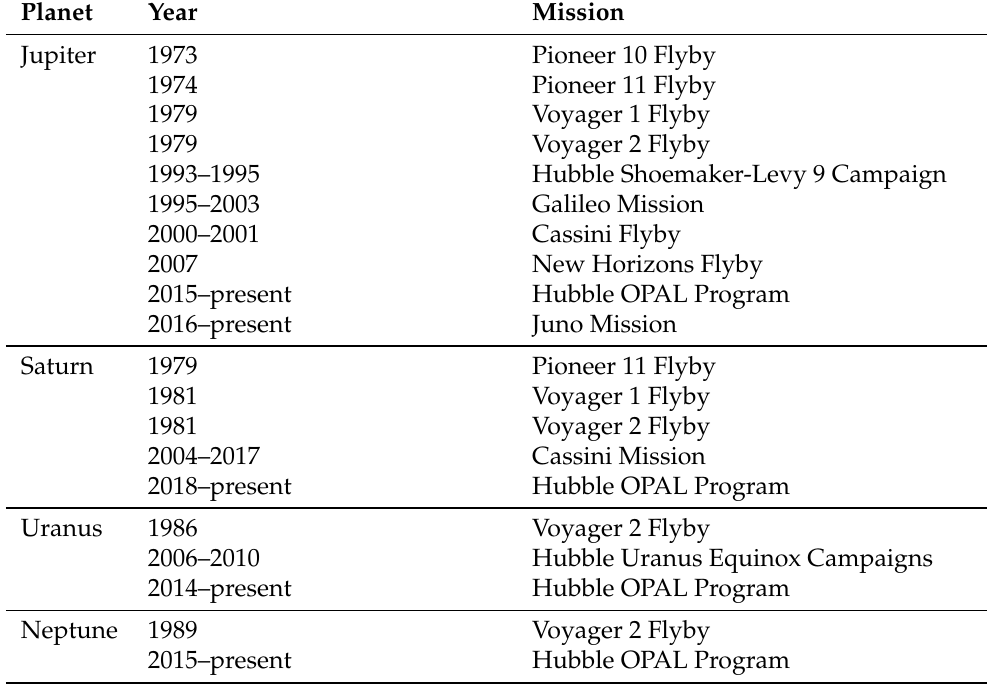
Figure 1. Timeline of spacecraft observations relative to planetary season. Solid lines indicate the subsolar latitude (a proxy for season) for each planet and horizontal dashed lines indicate equinox crossings; peaks and trough indicate northern and southern hemisphere summer solstices, respectively. The major missions listed in Table 1 are plotted, demonstrating the lack of coverage for Uranus and Neptune. The Hubble era began in late 1993 (after the installation of corrective optics) and is indicated by the shaded area on the right. Table 1. Dedicated Imaging Campaigns from Robotic